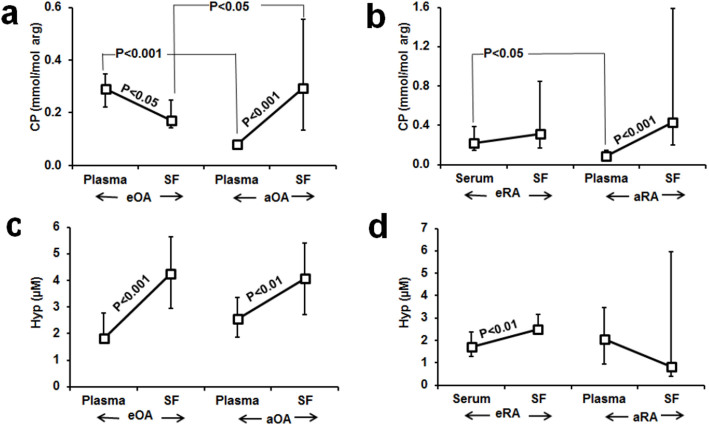
Citrullinated protein and hydroxyproline in plasma and synovial fluid compartments in early-stage and advanced arthritis.CP: (a) osteoarthritis and (b) rheumatoid arthritis. Hyp: (c) osteoarthritis and (d) rheumatoid arthritis. Data are median (lower – upper quartile); for eOA, n = 16; aOA, n = 17, eRA, n = 10 and aRA, n = 22. Lines joint median estimates in plasma/serum to synovial fluid from the same subject groups.